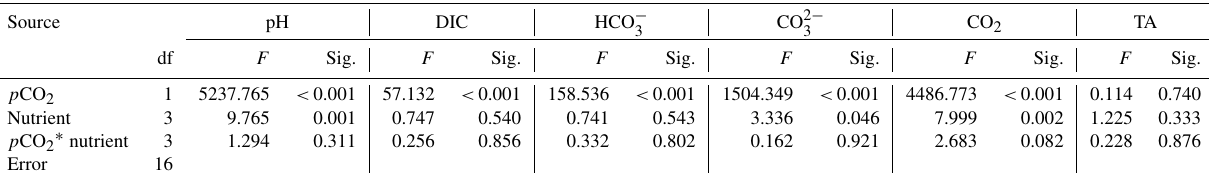
Table 2. Two-way multivariate analysis of variance for the effects of p CO 2 and nutrients on pH, dissolved inorganic carbon (DIC), HCO − CO 2 − , CO 2 and total alkalinity (TA) in the seawater. The p CO 2 ∗ nutrient means the interactive effect of p CO 2 and nutrients, df means 3 degree of freedom, F means the value of F statistic, and Sig. means p value.